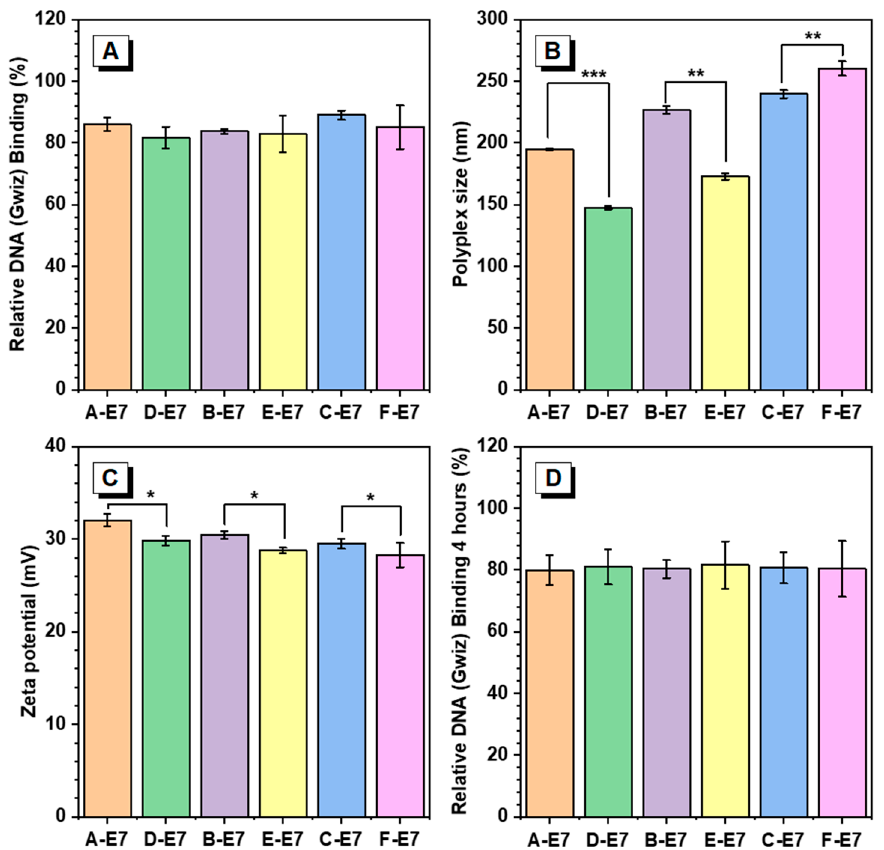
Figure 3. Polyplex characterisation results at a ratio of 30:1 (polymer/DNA w / w ) . (A) Relative DNA binding of HPAEs. (B) Polyplex sizes of different HPAEs. (C) The corresponding zeta potentials of the polyplexes. (D) Relative DNA binding of HPAEs post 4 h incubation at 37 °C. One-way ANOVA with posthoc Dunnett test was used to analyse the experiment’s results. P values of less than 0.05 were considered significant (* p < 0.05, ** p < 0.01, *** p < 0.001).